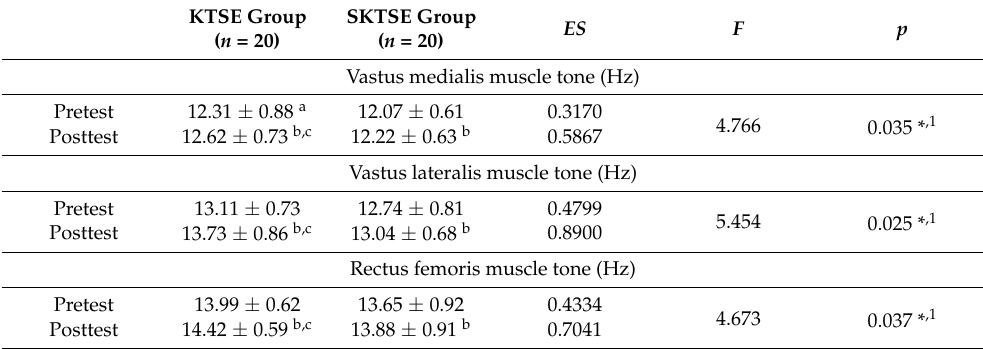
Table 3. Comparison of muscle tone between the KTSE and SKTSE